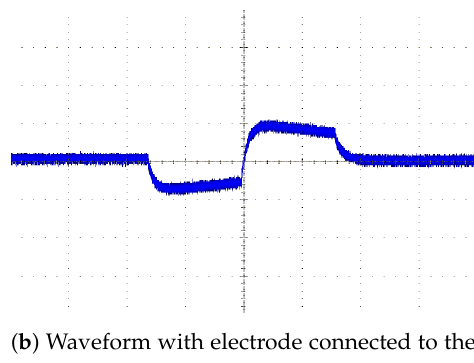
skin showing the current limit in operation. Figure 7. Stimulator pulse waveforms (oscilloscope settings 50 V/div, 100 µ